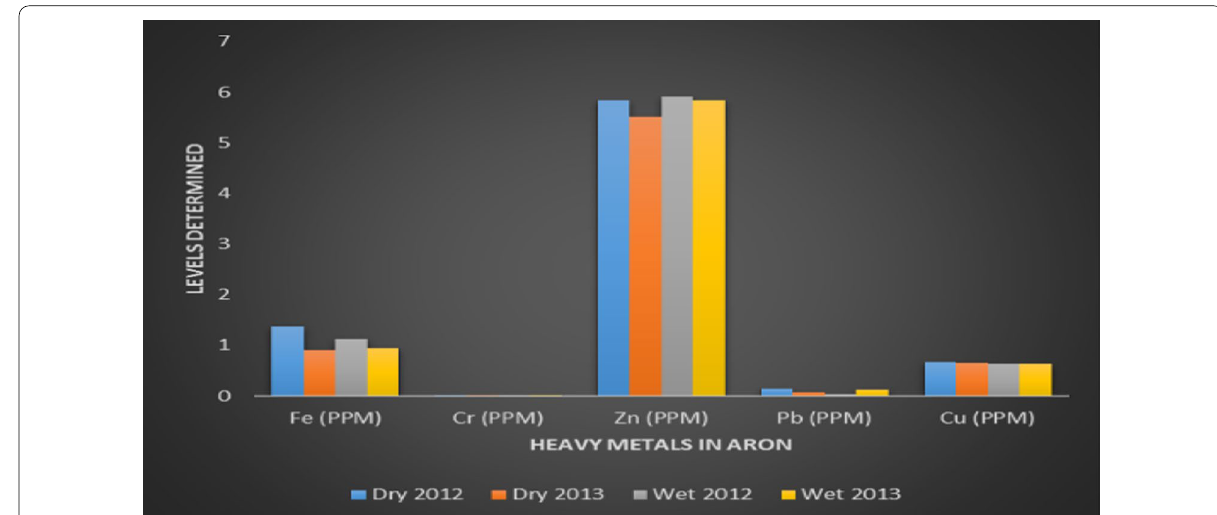
Fig. 8 Seasonal variations in heavy metals in O. niloticus collected from Asejire Reservoir